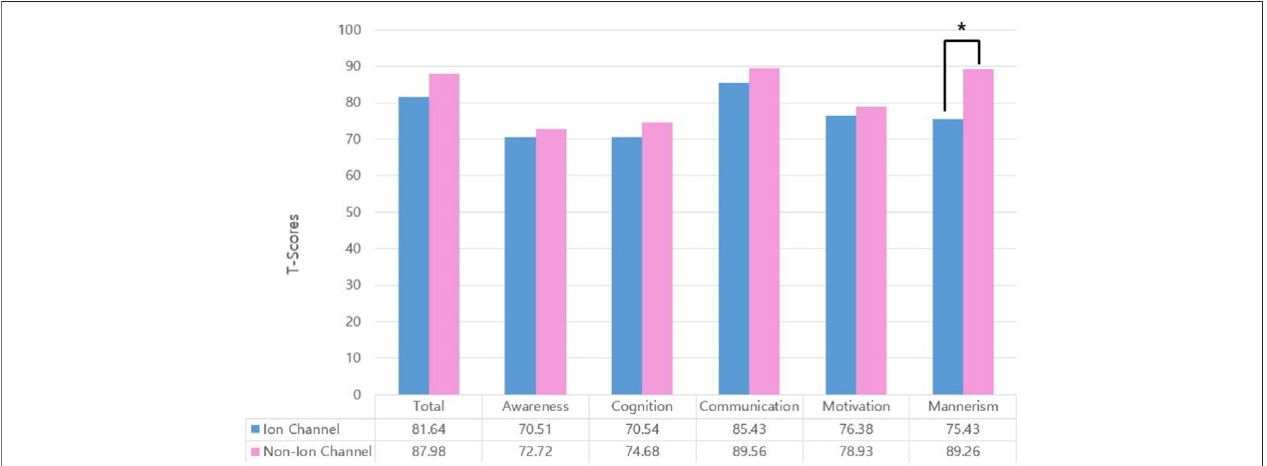
FIGURE 3 | Group comparison of Social Responsiveness Scale (SRS) total T-scores and subscale T-scores. Comparison of children with variants in ion channel- relatedgenesversusothers.Onlymannerismsubscalescoresweresigni fi cantlydifferent(* p (cid:1) 0.003). Total: SRStotalT-score; awareness: socialawarenesssubscale T-score; cognition: social cognition subscale T-score; communication: social communication subscale T-score; motivation: social motivation subscale T-score; mannerism: mannerism subscale T-score.